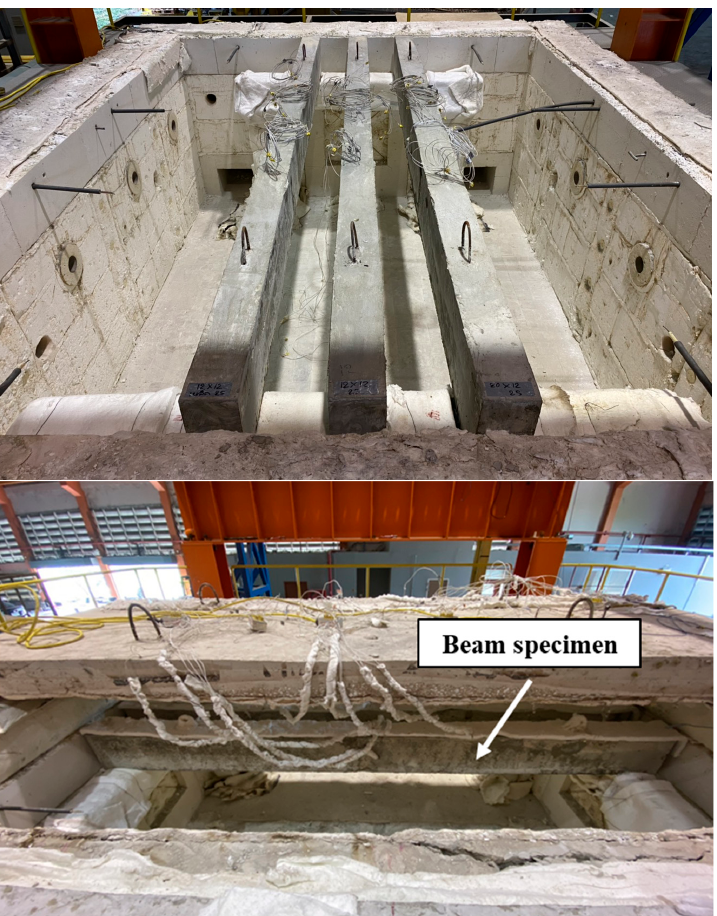
Figure 6. Fire test setup.